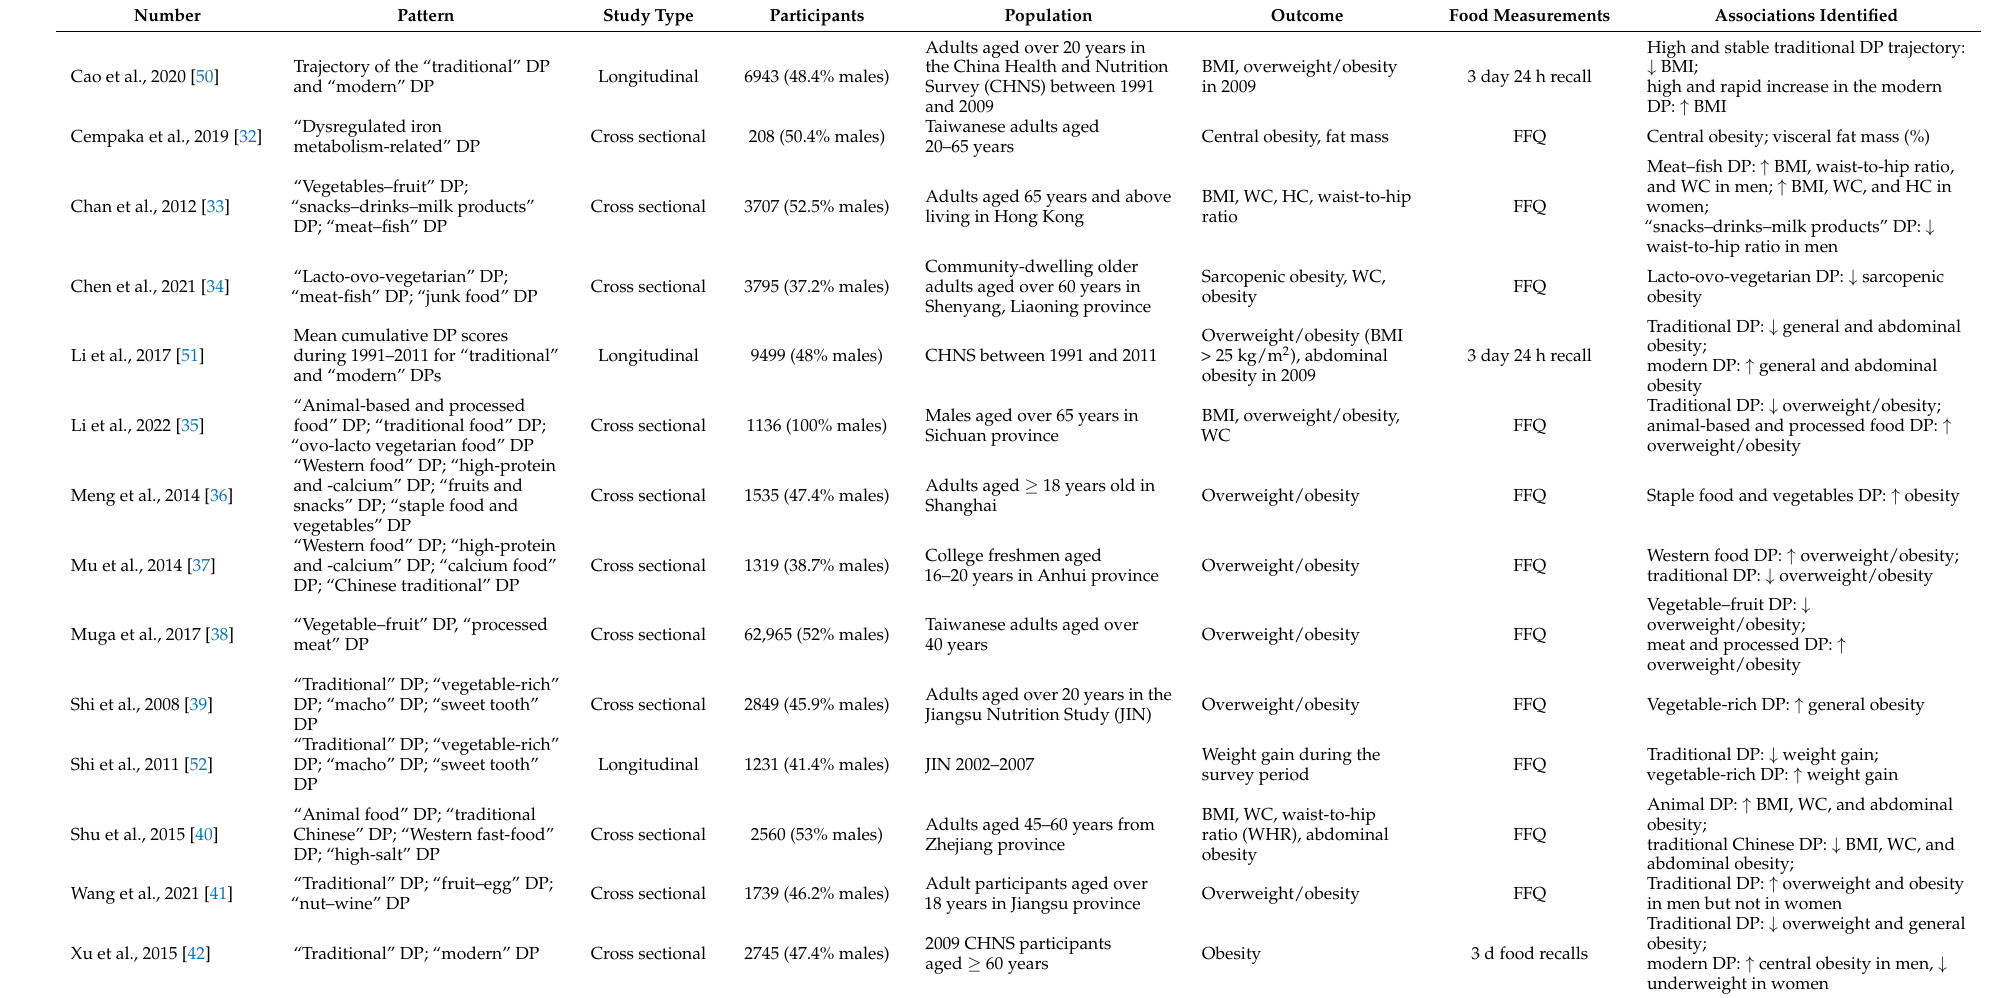
Table 1. Summary of characteristics of included studies on dietary patterns and obesity or weight